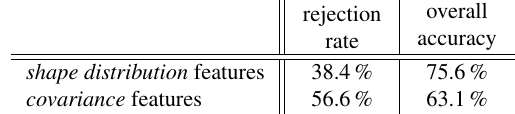
Table 1: Rejection rates and overall accuracies for classifications based on shape distribution and covariance